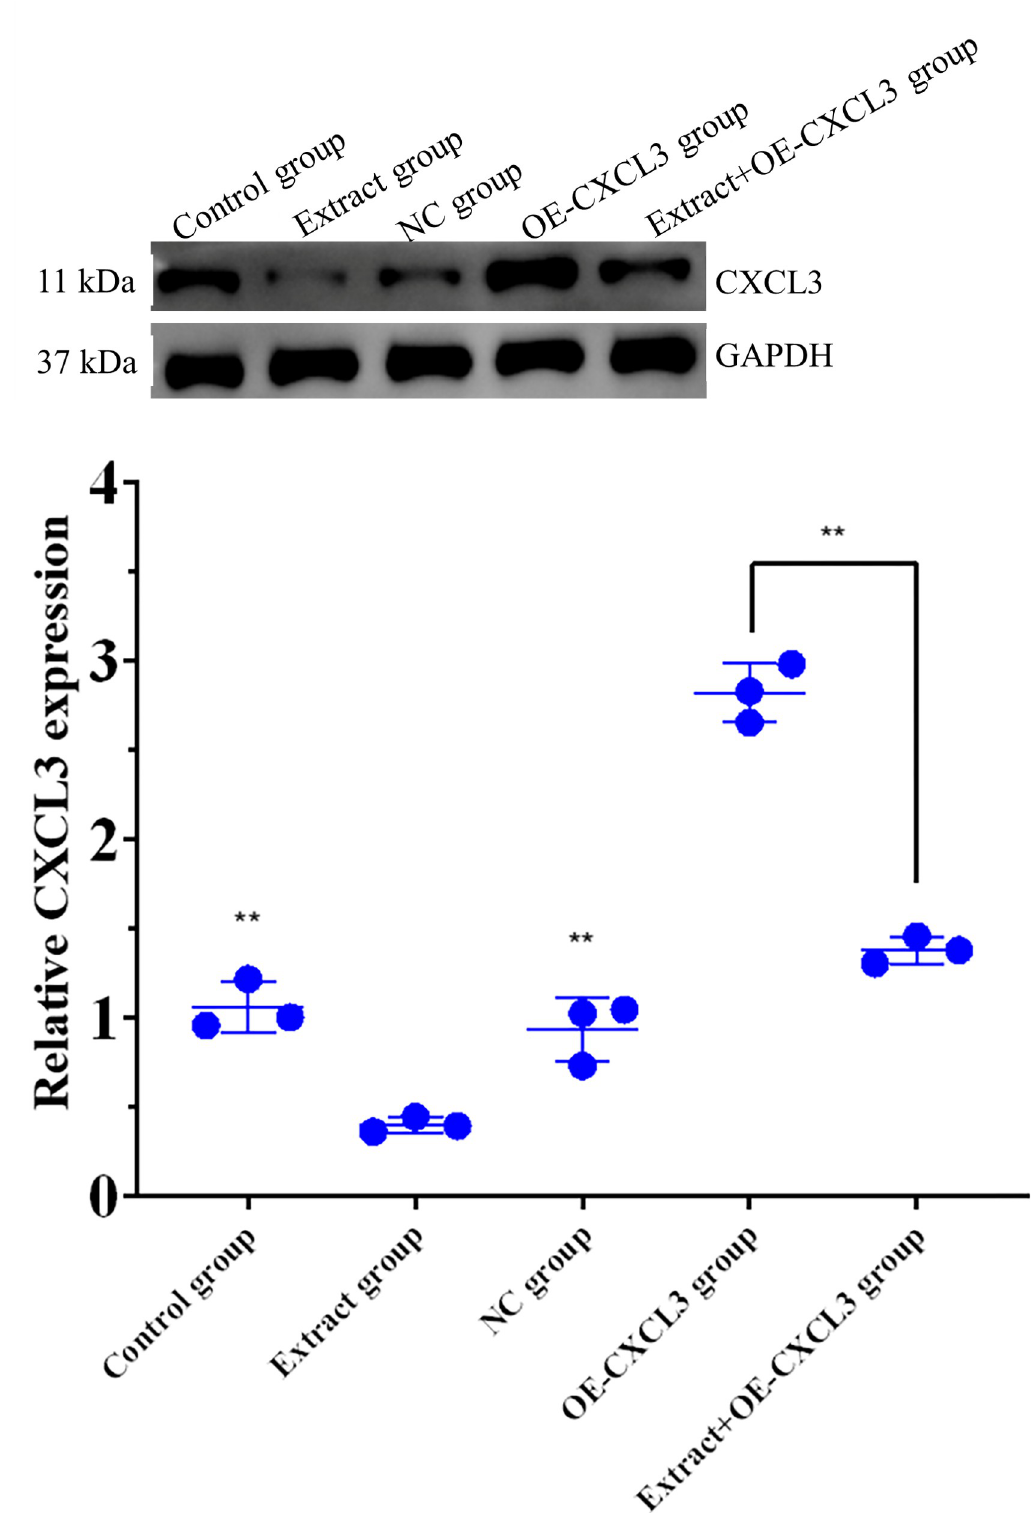
Fig 8. Expression of CXCL3 in control, extract, and transfection groups. ( a ) Protein expression of CXCL3 detected by western blotting. ( b ) Relative expression of CXCL3 determined by real-time PCR. ( �� p < 0.01 compared to the extract group).